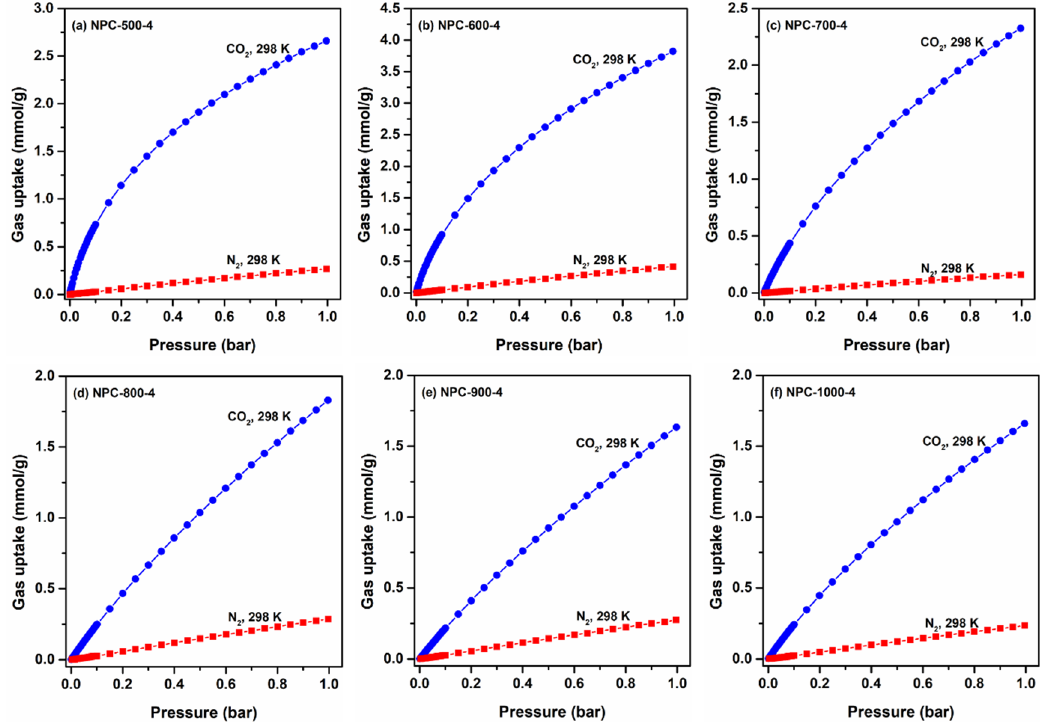
Figure 10. CO 2 and N 2 adsorption isotherms of NPC-y-4 ( a – f ) at 298 K.